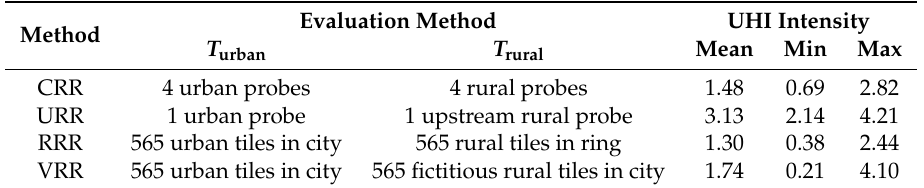
Figure 8. Comparison of the UHI intensity profiles of an average day using the four evaluation methods. Table 12. The four different evaluation methods and the mean, min and max values of the average day UHI intensity (in